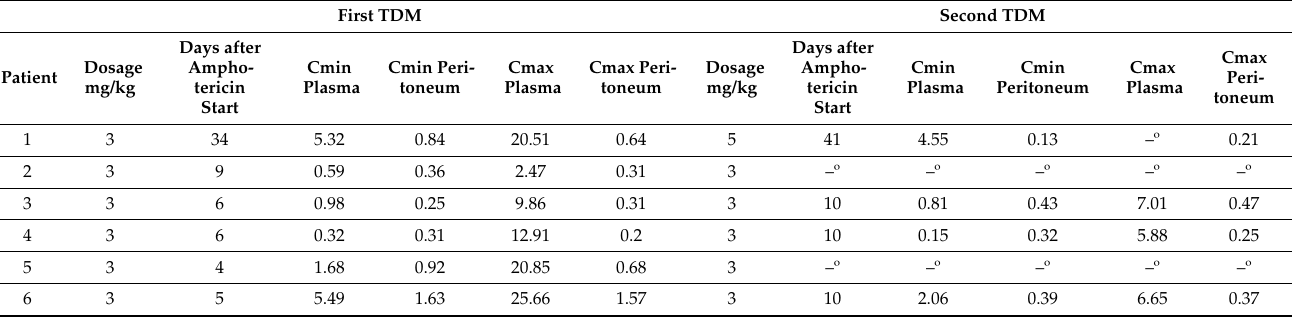
Table 3. Levels of amphotericin-B in the blood (Plasma) and peritoneal (Peritoneum) fluid. First TDM Second